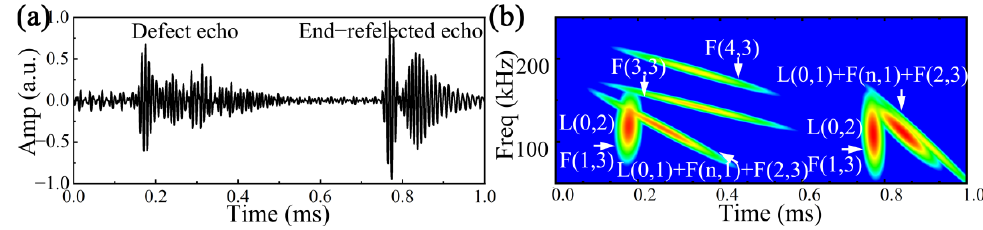
Figure 6. ( a ) Time–frequency diagrams of the UGW synthesized signal at the propagation distance of 0.8 m and ( b ) time domain diagram of the UGW synthesized signal at different propagation distances.